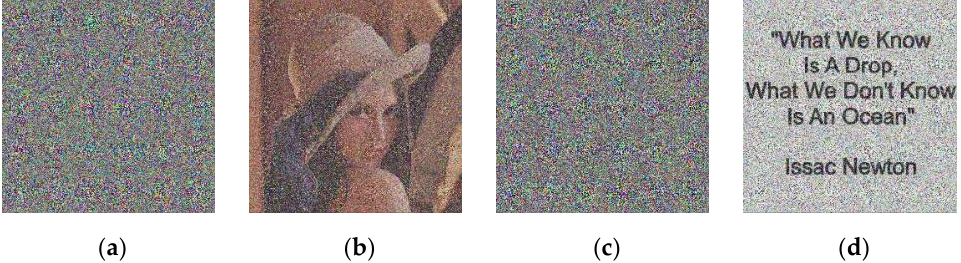
Figure 12. ( a ) Lena_encrypted.jpeg under a salt and pepper noise attack with a density of 50%, ( b ) Decryption of Lena_encrypted.jpeg after noise attack with a density of 50%, ( c ) Message_encrypted.jpeg under a salt and pepper noise attack with a density of 50%, ( d ) Decryption of Message_encrypted.jpeg after noise attack with a density of 50%.